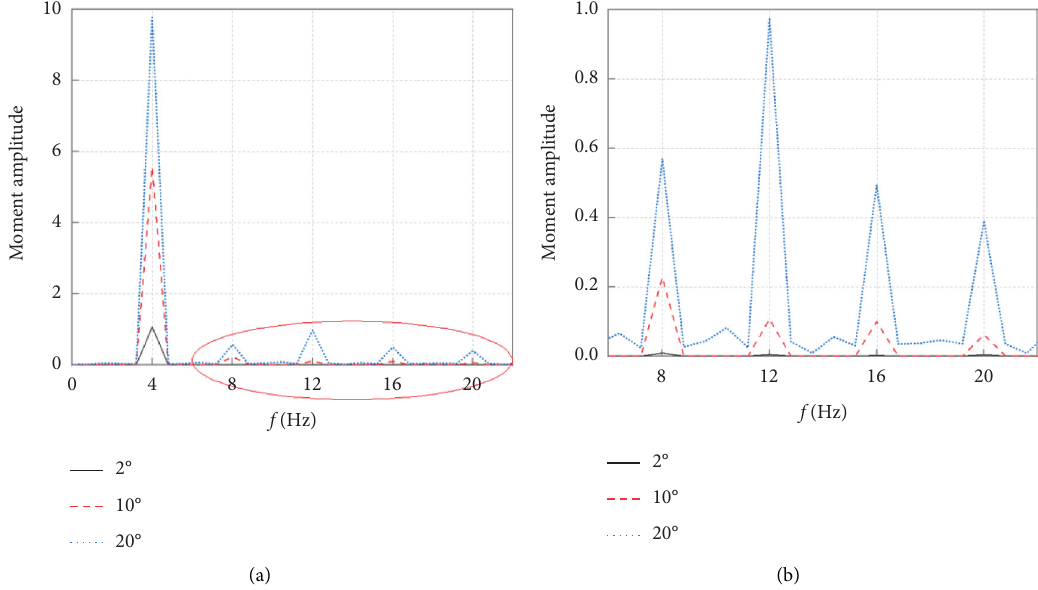
Figure 12: Aerodynamic moment spectrum under different torsional amplitude vibrations of the single frequency. (a) Complete spectrum. (b) Locally amplified spectrum.